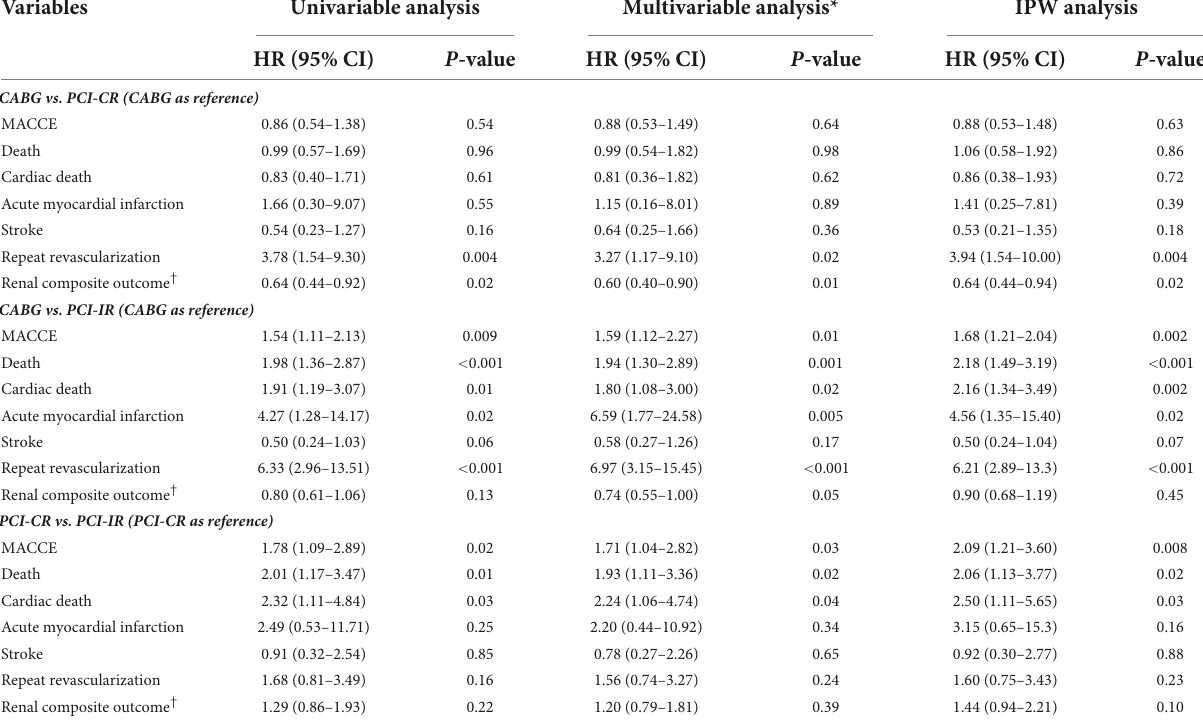
TABLE 4 Clinical outcomes at 5 years in the CABG, PCI-CR, and PCI-IR